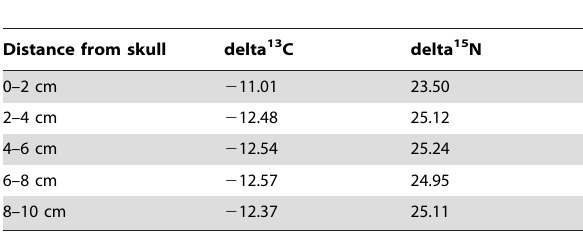
Table 2. Stable isotope analysis of mummy